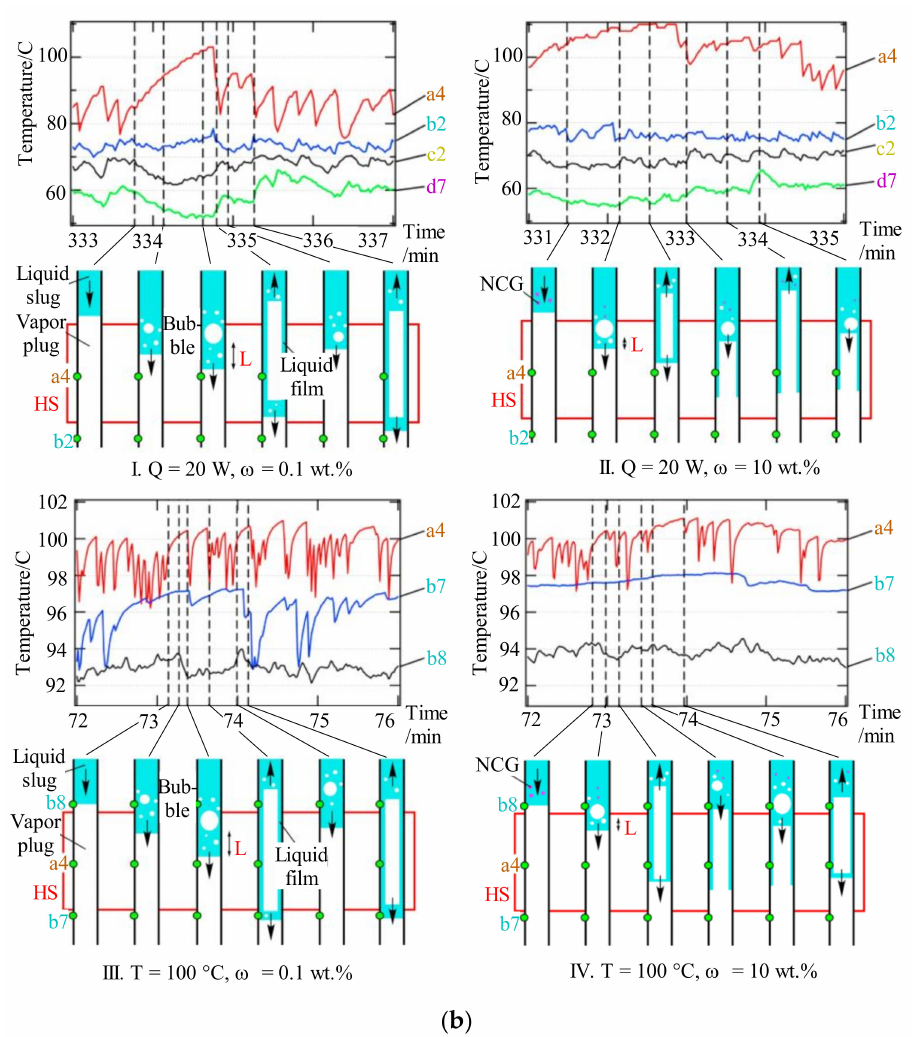
Figure 6. Effect of non-condensable gas on heat pipe [120]. Senjaya et al., (2014). ( a ) EOHP with heat flux constant and wall temperature constant. ( b ) Measurement point temperature status and flow image of